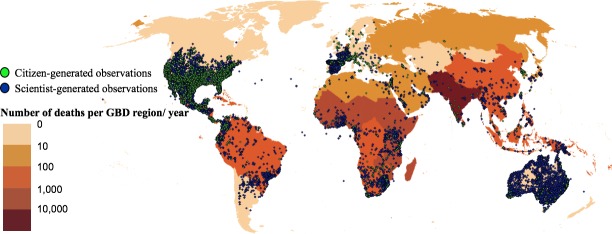
Geographical distribution of MIVS citizen-generated (n = 9,113) and scientist-generated (n = 70,697) observations on global map illustrating snakebite mortality for GBD regions of the world.The time frames for citizen-generated and scientist-generated observations are from 1967 to 2017 and 1700 to 2016 respectively. The color scale illustrates the mortality for these regions based on figures provided by Kasturiratne et al. (2008) [12]. Source: Made with Natural Earth. Free vector and raster map data available from www.naturalearthdata.com. The map (countries cultural theme version 3.1.0) is adapted and projected in the World Robinson coordinate reference system on QGIS 2.18.2. Abbreviations: GBD, global burden of disease; MIVS, medically important venomous snakes.